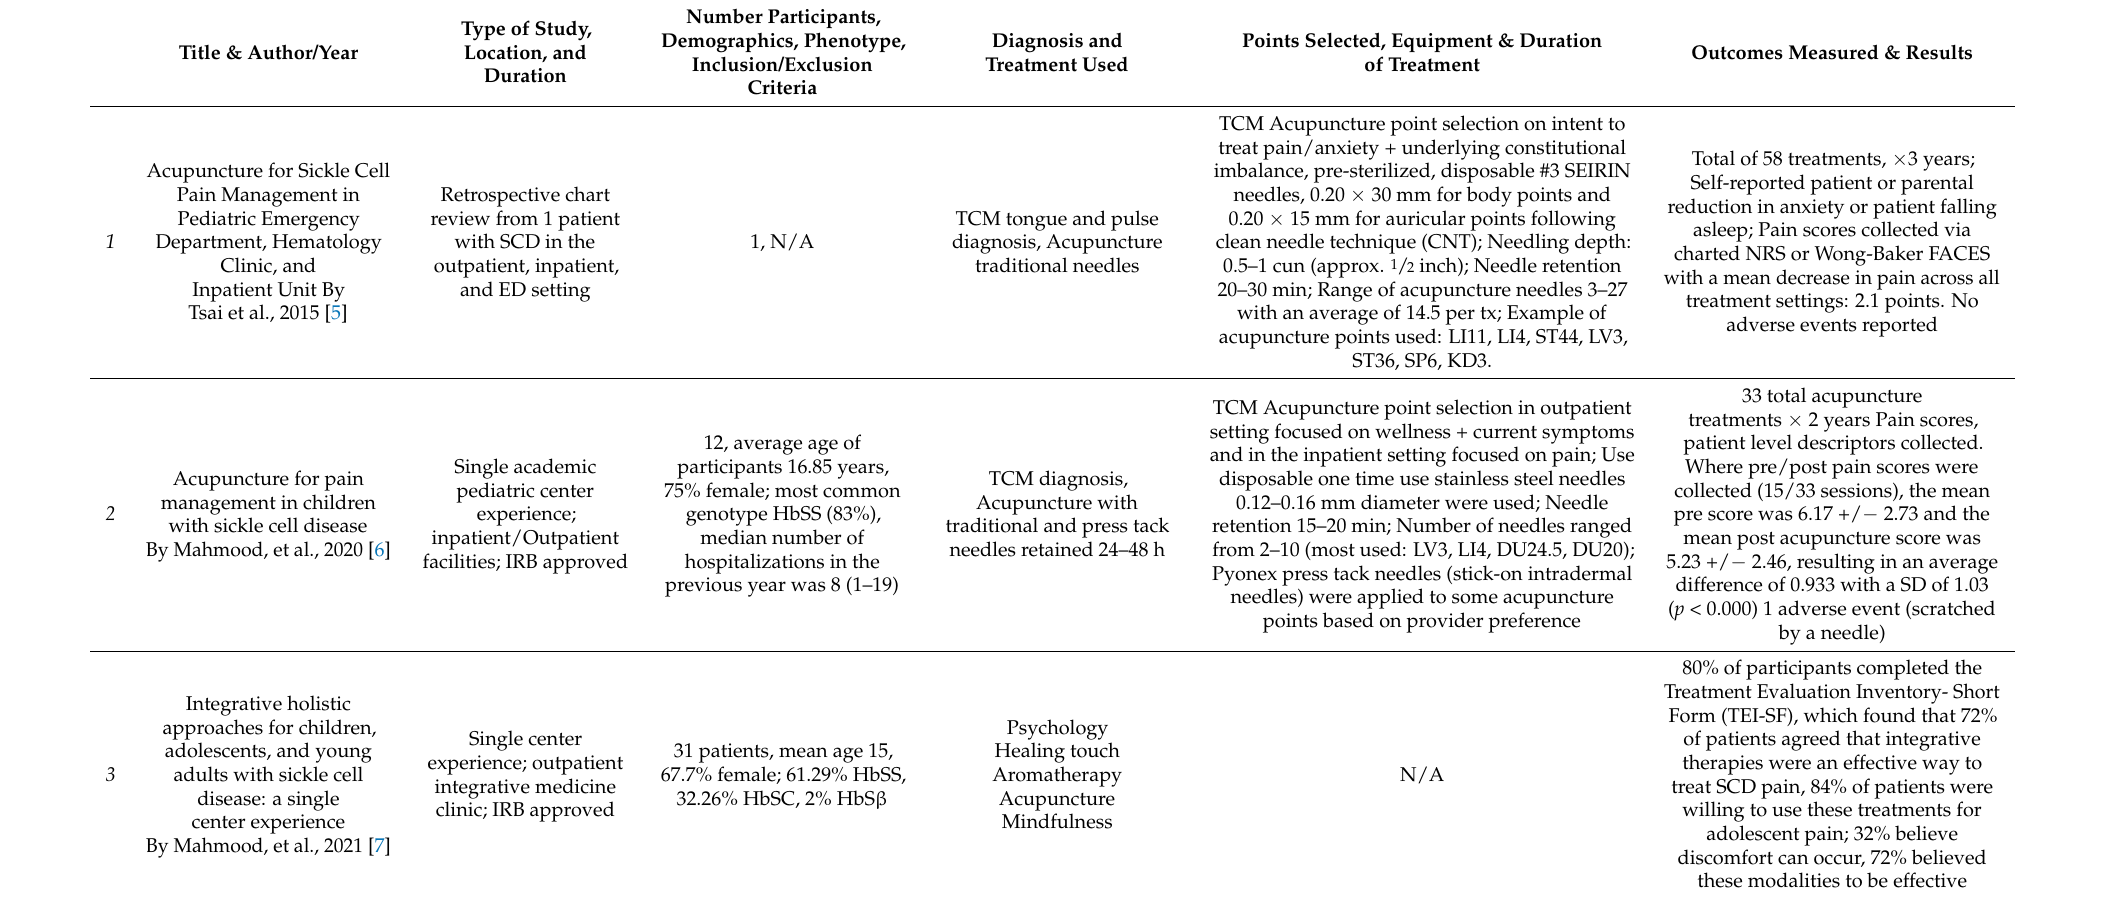
Table 1. Summary of Research Articles on the use of Acupuncture for Pain Management in Pediatric Patients with Sickle cell